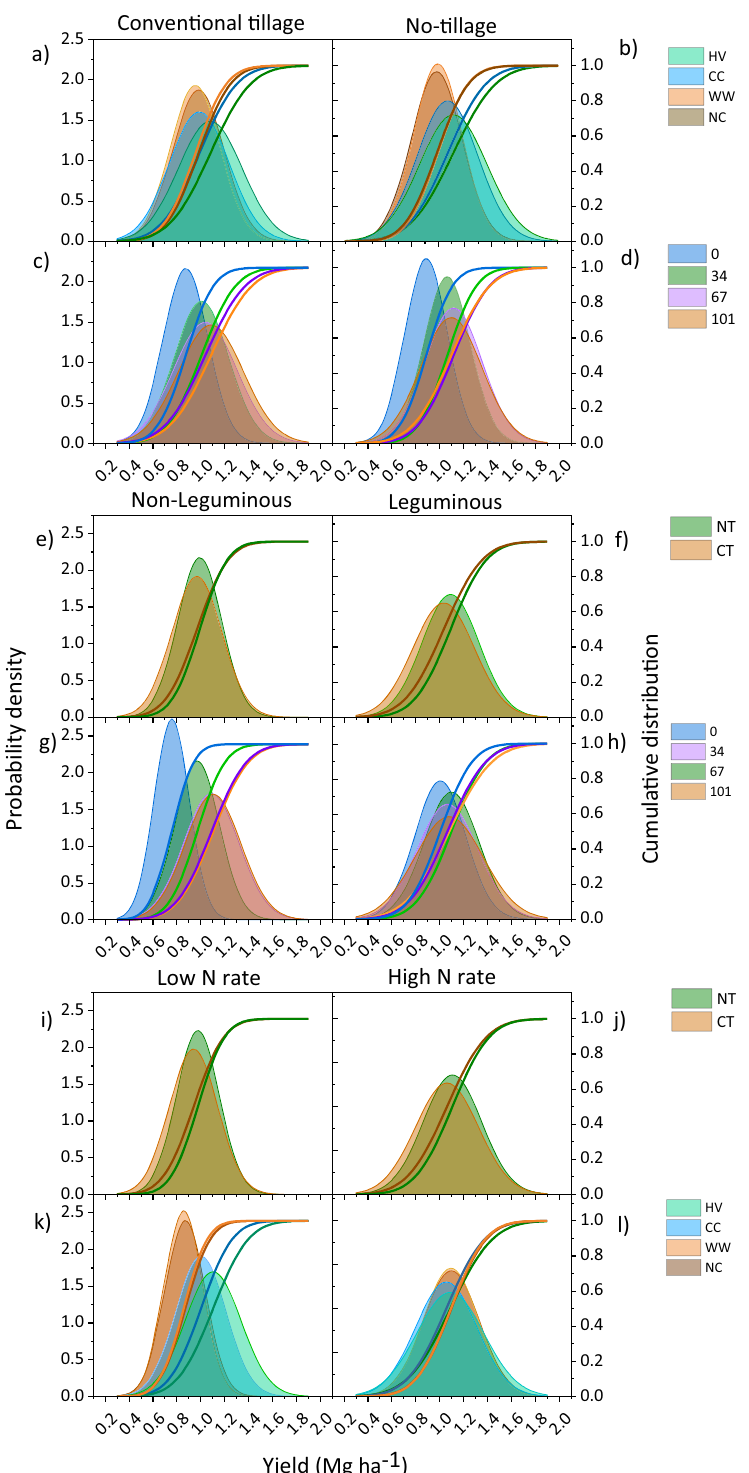
Fig. 3 Cumulative distribution (lines) and probability density (shaded areas) of cotton yield across low- and high-yielding environmental conditions. The graphs represent the interactive effect of the tillage system ( a – d ), cover crop type ( e – h ), and N rate ( i – l ) with the other two factors. CT conventional tillage, NT no-tillage, NC no cover crop, WW winter wheat, CC crimson clover, HV hairy Relationship between soil resilience indicators and yield sta- bene fi ts than NC (control no cover crop treatment). CC, the other bility across drought and wetness severities . Among soil resi- legume cover crop, outperformed NC in D, RD, NNhy, NN, and RW climates, but only when it was planted in an NT system. lience metrics, SOC provided the strongest explanation However, management systems with both HV and CC cover ( R 2 = 0.87) for yield stability under a range of drought and wetness severities (Fig. 6). ANOVA tests showed that intercepts, crops exhibited lower yields than those with NC in wet years.